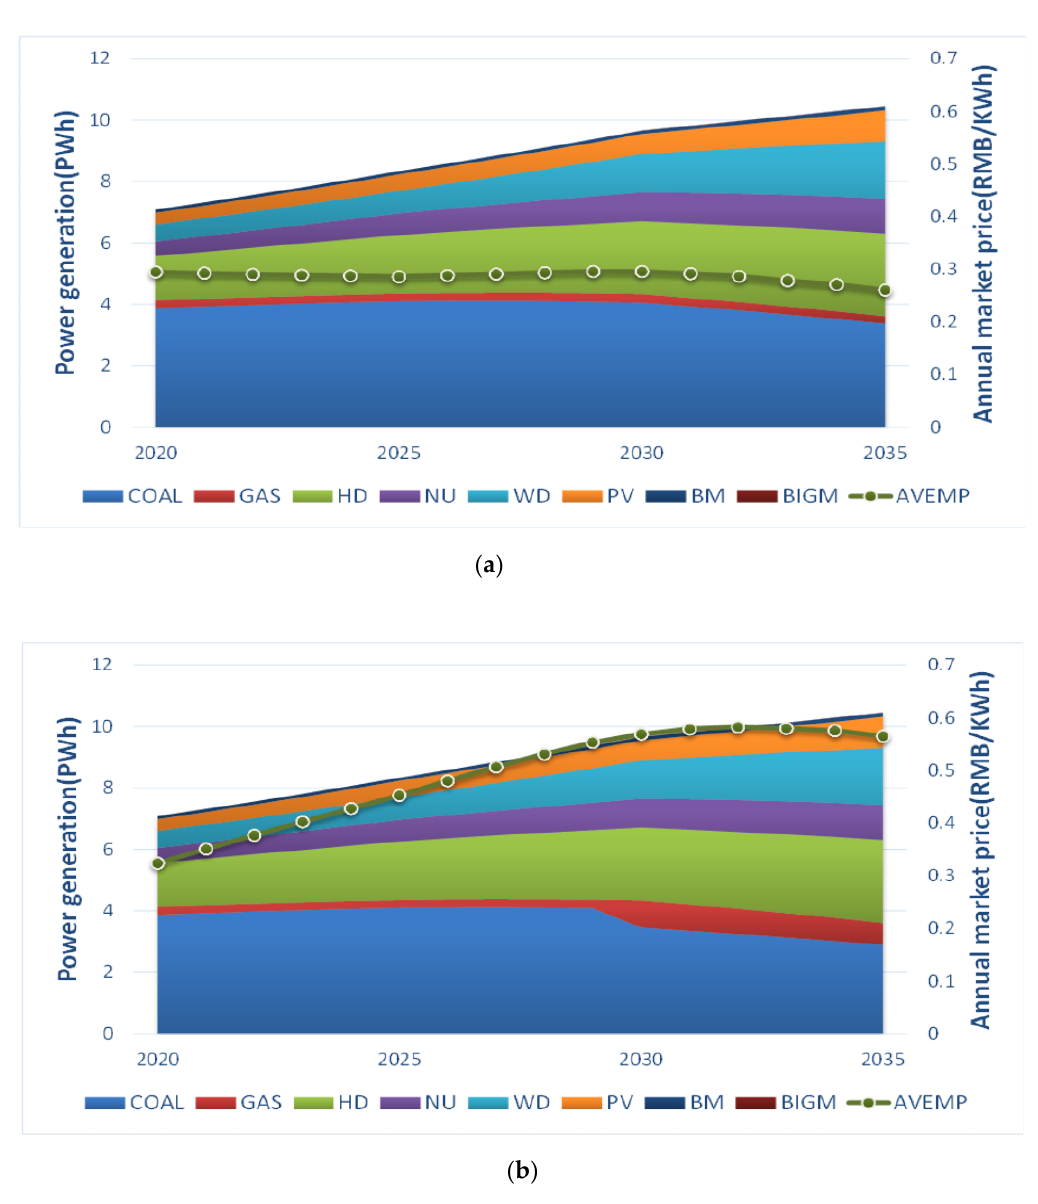
Figure 9. Comparison of China’s electricity generation mix and annual market price between the BAU and aggressive carbon policy scenarios. ( a ) MO carbon policy scenario; ( b ) BAU carbon policy scenario.